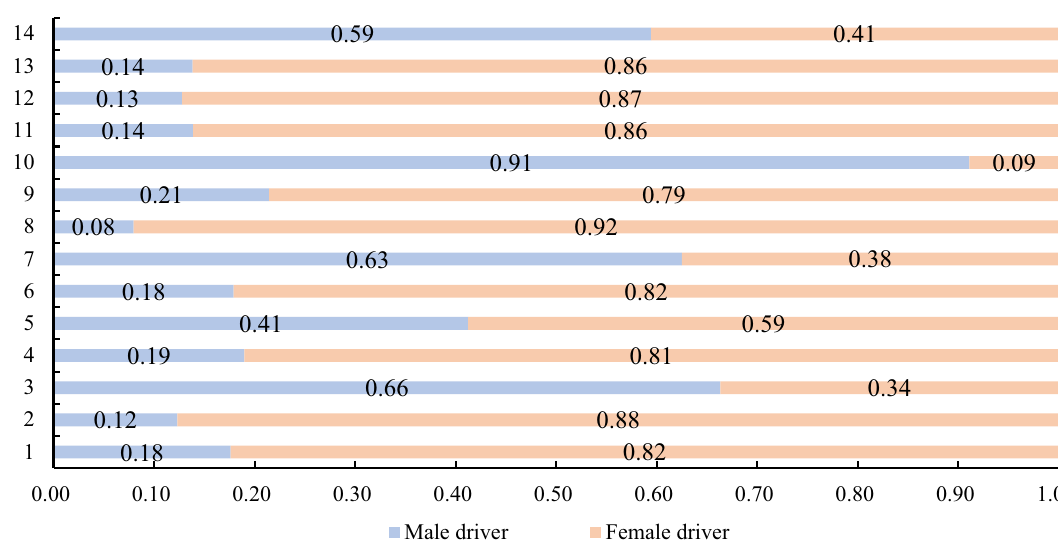
Figure 14. Effect score of the RTCRWS for male and female drivers.